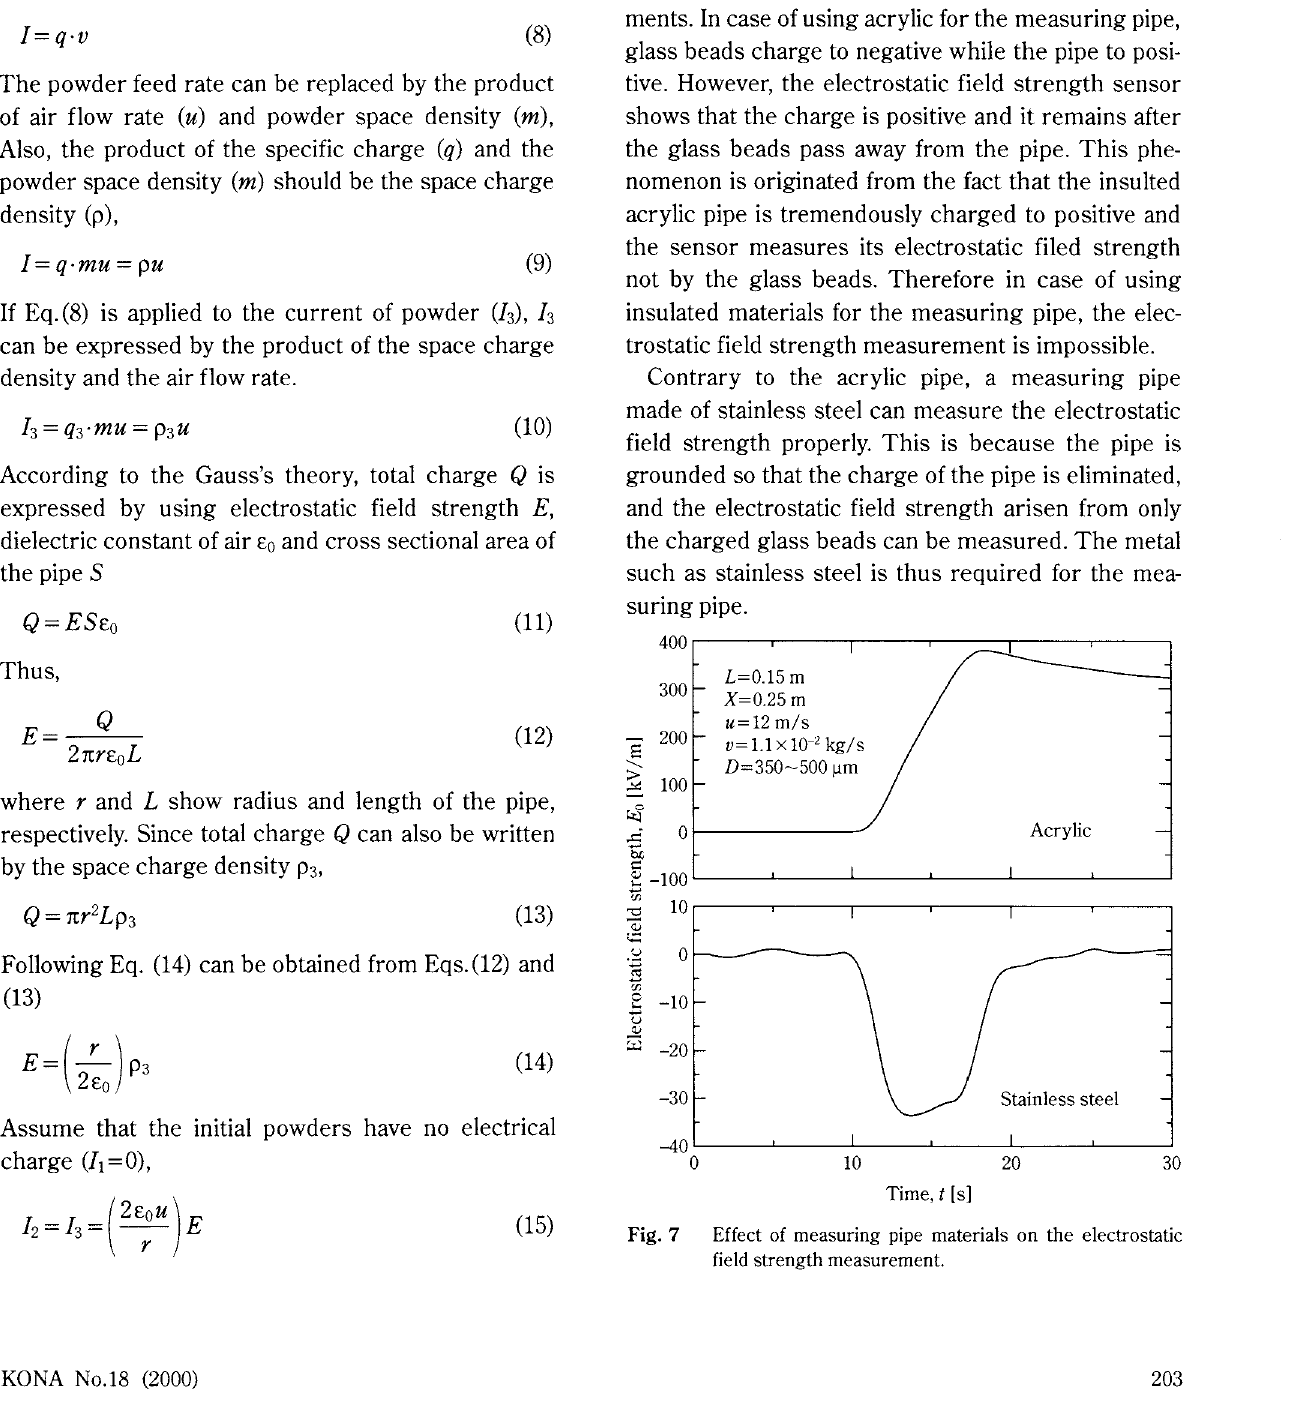
Effect of measuring pipe materials on the electrostatic field strength